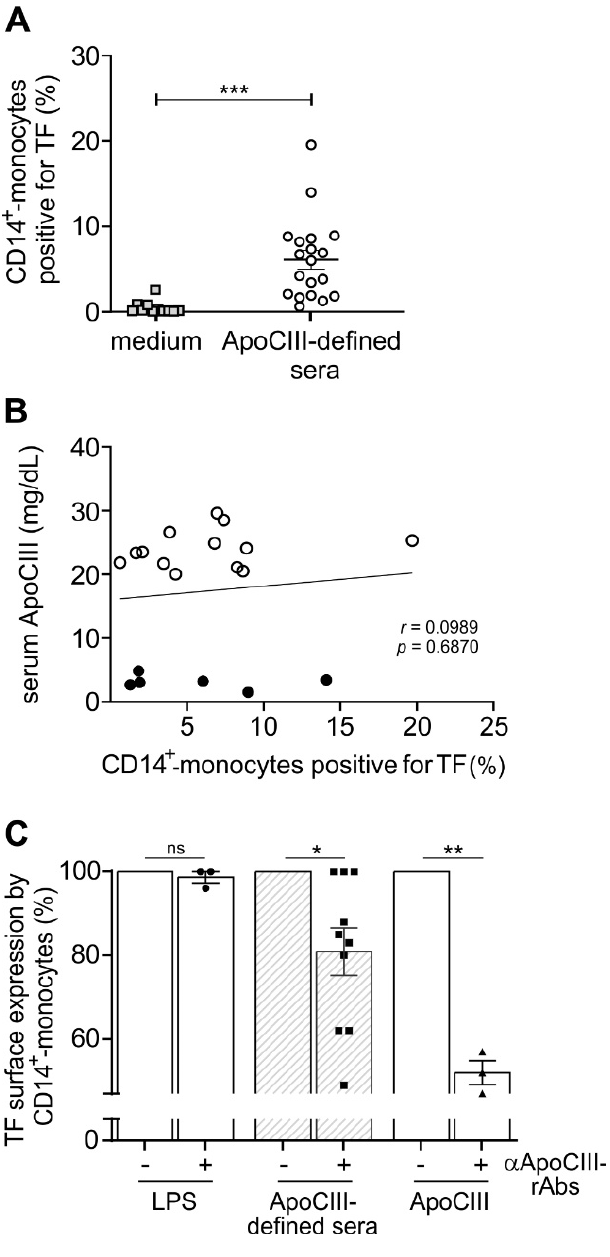
Figure 4. Effect of sera with measured concentrations of ApoCIII on surface TF expression by CD14 + -monocytes. Panel A shows the percentages of CD14 + -monocytes expressing TF from PBMCs incubated for 3 h with or without 10% sera obtained from 19 individuals displaying different serum ApoCIII levels ranging from 1.5 to 29.6 mg/dL. Data are expressed as mean ± SEM ( n = 11–19) and were analyzed by unpaired t -test with Welch correction. *** p < 0.001. Panel B displays a scatter plot with a linear regression curve showing the relationship between the percentages of CD14 + -monocytes expressing TF and the ApoCIII concentrations of the sera used to stimulate PBMCs. The r-value determined by Pearson correlation is displayed. Panel C reports CD14 + -monocytes expressing TF from PBMC samples incubated for 3 h with either 50 µ g/mL ApoCIII, sera with known concentrations of ApoCIII (ApoCIII-sera) or 100 ng/mL LPS in the presence or absence (as 100%) of 60 µ g/mL ApoCIII-neutralizing rAbs. Statistics of data refer to the effects of anti-ApoCIII- recombinant antibodies ( α ApoCIII-rAbs) on each treatment, and were evaluated by one sample t-test. * p < 0.05; ** p < 0.01; n =